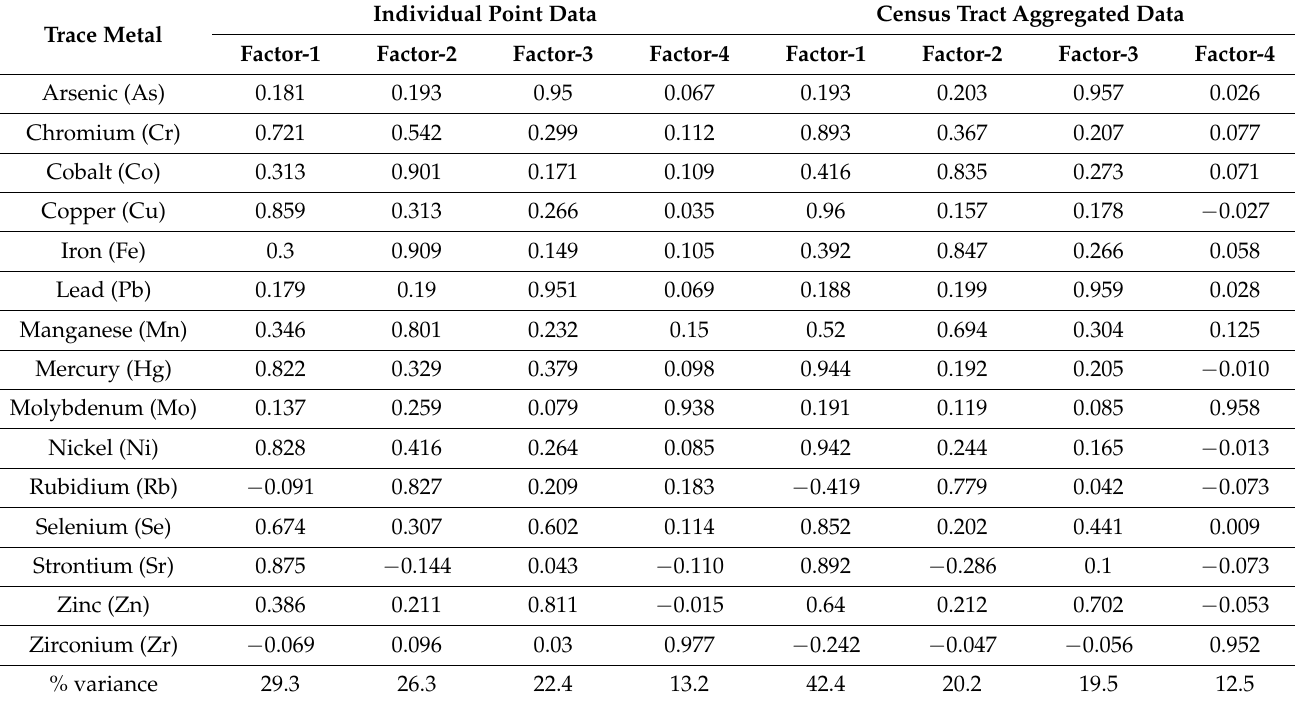
Table 4. Syracuse trace metal analytical error varimax-rotated factor dimensions.